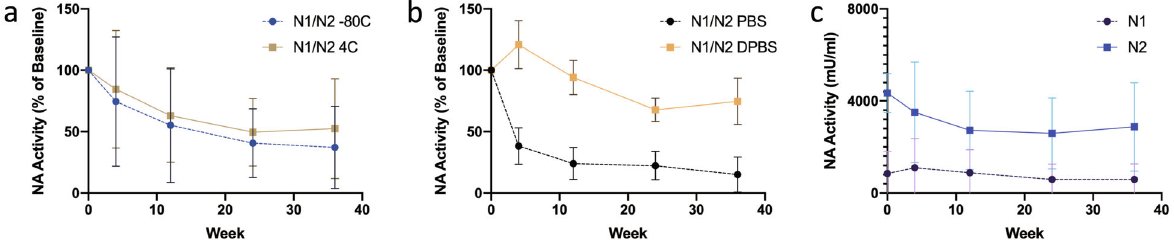
Fig. 2 Grouped analysis demonstrating the effects of storage temperature, buffer choice, and NA type on NA activity in vitro over 36 weeks. NA activity measured by MU-NANA assay at weeks 0, 4, 12, 24, and 36 was grouped by temperature conditions ( a ), buffer choice ( b ), and NA type group ( c ). In a , N1/N2 − 80 °C represents mean activity of N1 PBS − 80 °C, N1 DPBS − 80 °C, N2 PBS − 80 °C, and N2 DPBS − 80 °C and N1/N2 4 °C represents mean activity of N1 PBS 4 °C, N1 DPBS 4 °C, N2 PBS 4 °C, and N2 DPBS 4 °C. In b , N1/N2 PBS represents mean activity of N1 PBS − 80 °C, N1 PBS 4 °C, N2 PBS − 80 °C, and N2 PBS 4 °C and N1/N2 DPBS represents mean activity of N1 DPBS − 80 °C, N1 DPBS 4 °C, N2 DPBS − 80 °C, and DN2 PBS 4 °C. In c , N1 represents mean activity of N1 PBS − 80 °C, N1 PBS 4 °C, N1 DPBS − 80 °C, and N1 DPBS 4 °C and N2 represents mean activity of N2 PBS − 80 °C, N2 PBS 4 °C, N2 DPBS − 80 °C, and N2 DPBS 4 °C. Activity presented as a percent ( a , b ) using week 0 as a baseline or as absolute activity in mU/ml ( c ). Points represent means and error bars represent standard deviation.